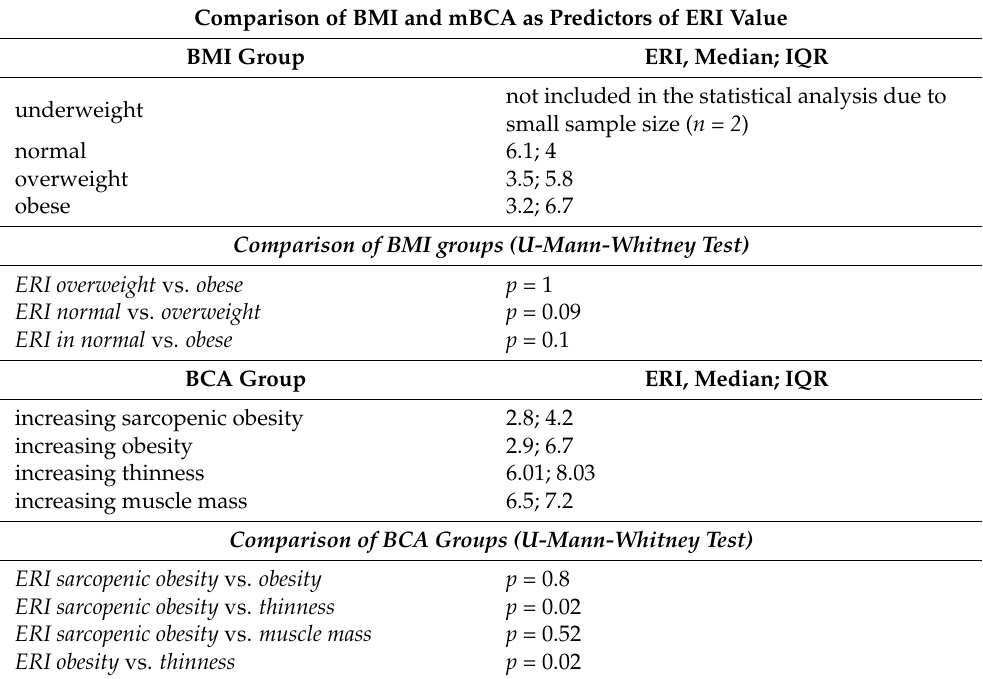
Table 3. BMI vs. BCA as predictors of ESA response (significant results in bold, p < 0.05). Comparison of BMI and mBCA as Predictors of ERI Value BMI Group ERI, Median; IQR not included in the statistical analysis due to underweight small sample size ( n = 2